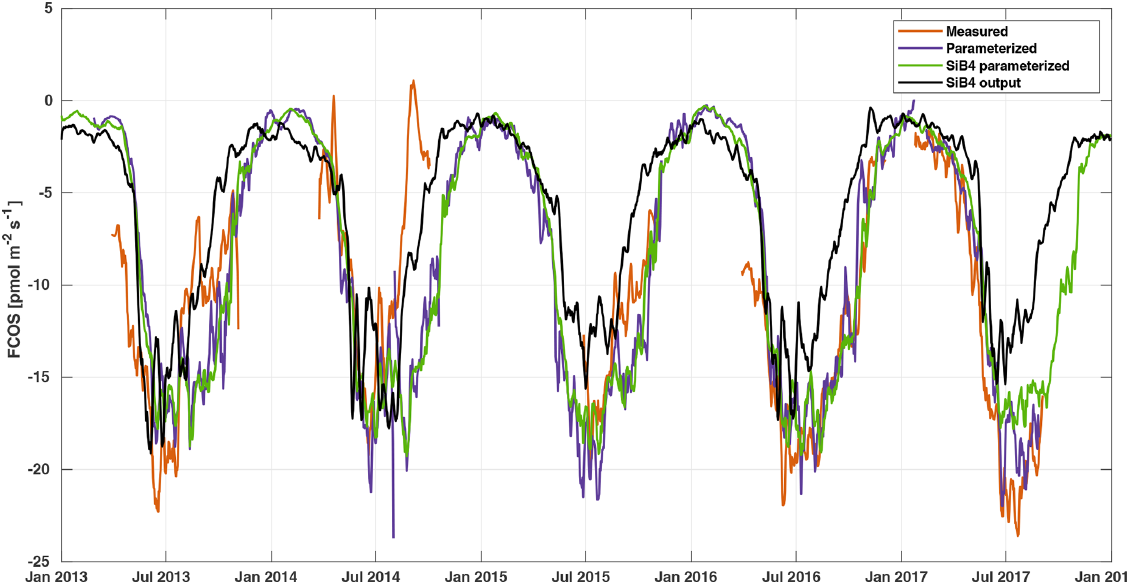
Figure 5. Weekly averaged FCOS from measurements (gap filled, orange line), parameterization (purple line), SiB4 parameterization (green line), and standard SiB4 output (black line) in Hyytiälä.